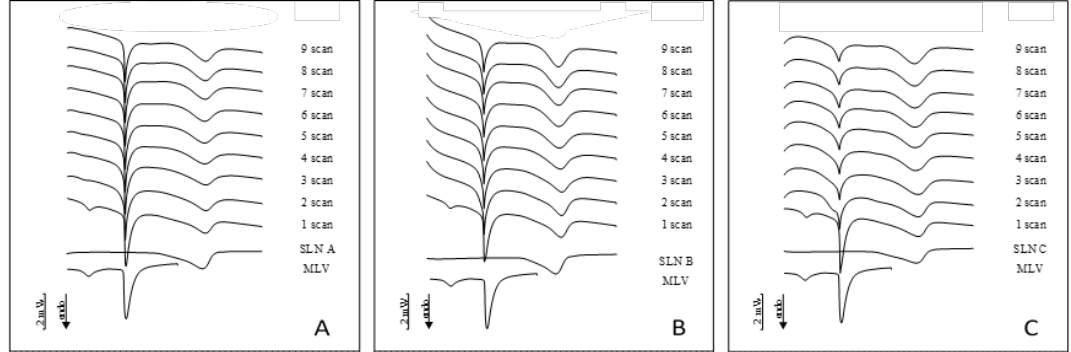
Figure 2. Differential scanning calorimetry (DSC) scans during the interactions of unloaded SLN with multi-lamellar (MLV) liposomes. A = SLN A; B = SLN B; C = SLN